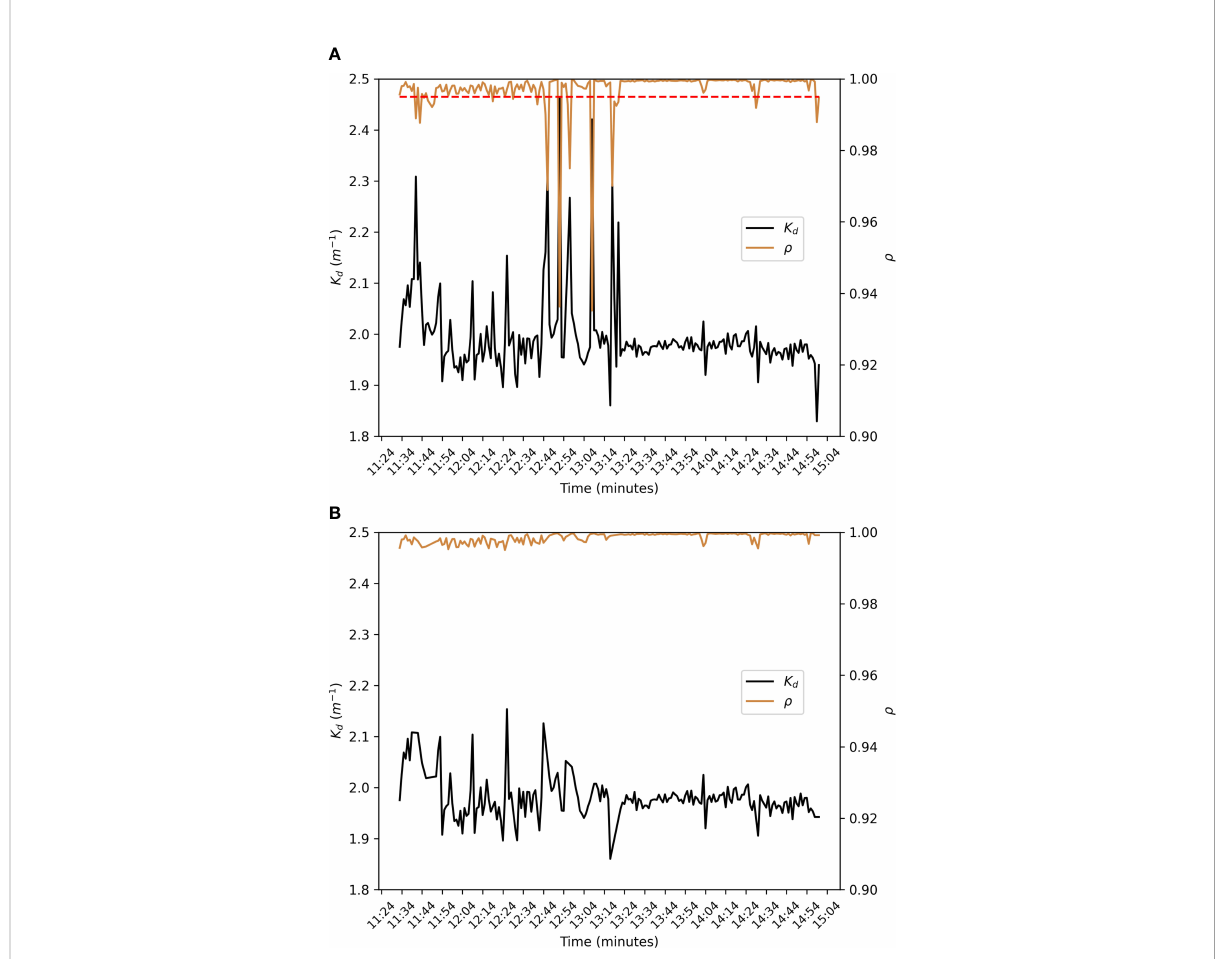
FIGURE 9 (A) Time series of K d estimated from the KduPRO working as a moored array of sensors. The red dashed line indicates the threshold of r =0.995 used as a quality control of the measurements. (B) The time series of K d estimated from the KduPRO, after applying the quality control and interpolating